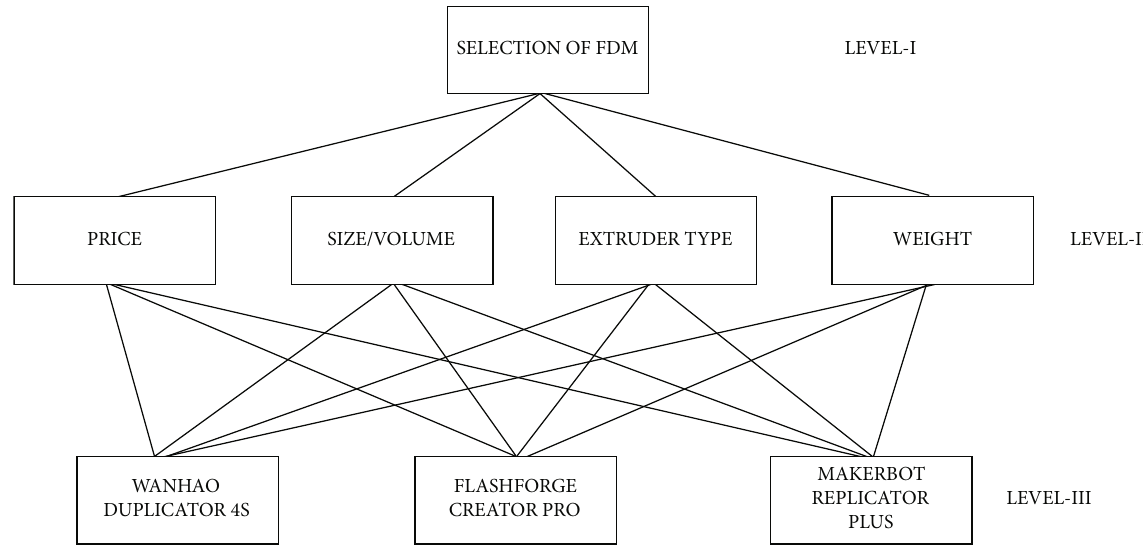
Figure 11: Hierarchy structure of machine selection problem